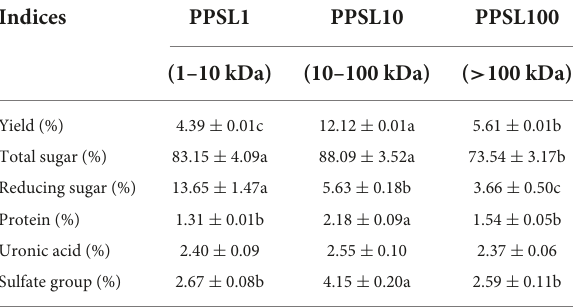
TABLE 1 Chemical properties of three PPSLs